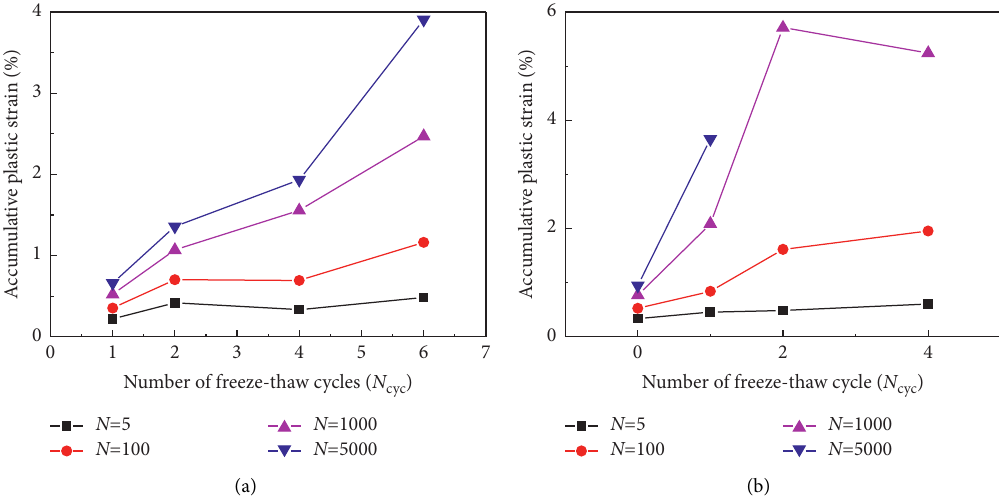
Figure 5: Relationship between the accumulative plastic strain and (N)